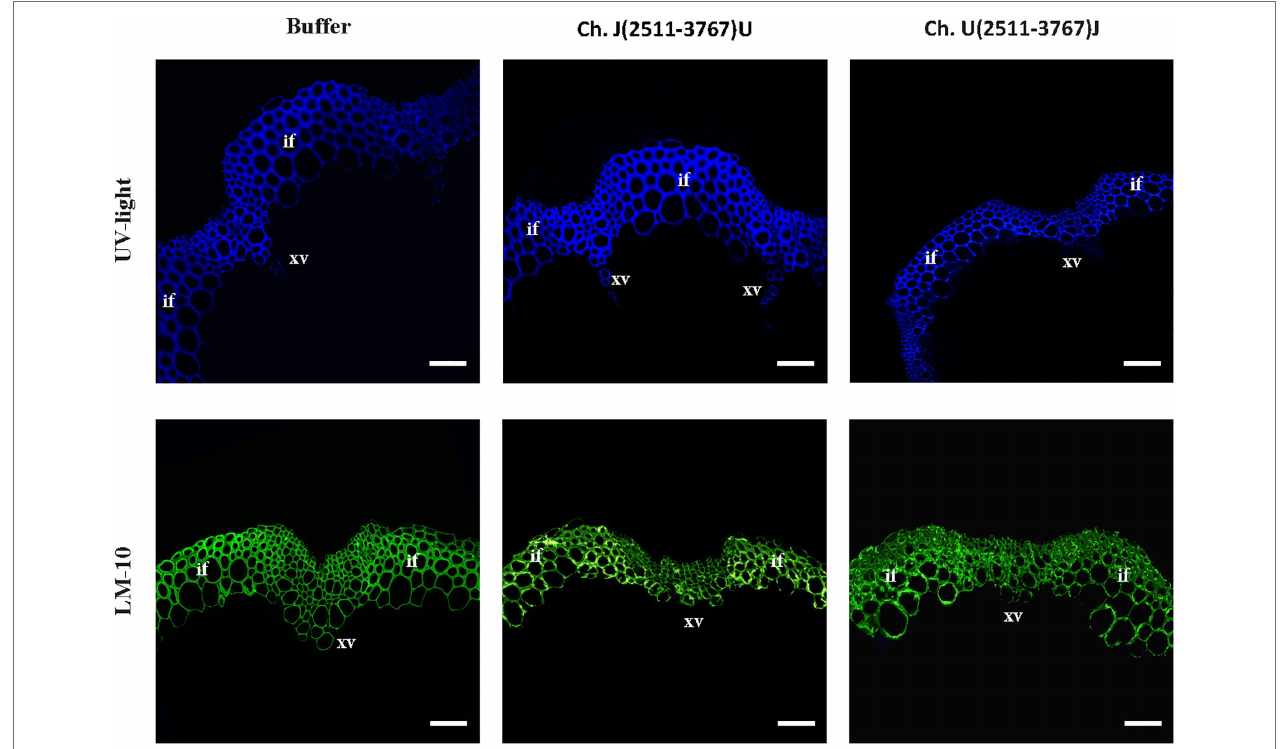
FIGURE 5 | Visualization of lignin by UV (upper row) and xylan (monoclonal antibody LM 10, bottom row ) in the inflorescence stem SCW of buffer-inoculated or TuMV chimeras centered in the P3 region of the viral genome. Bars indicate 100 μ m. Xylem vessels (xv) and interfascicular fibers (if) are